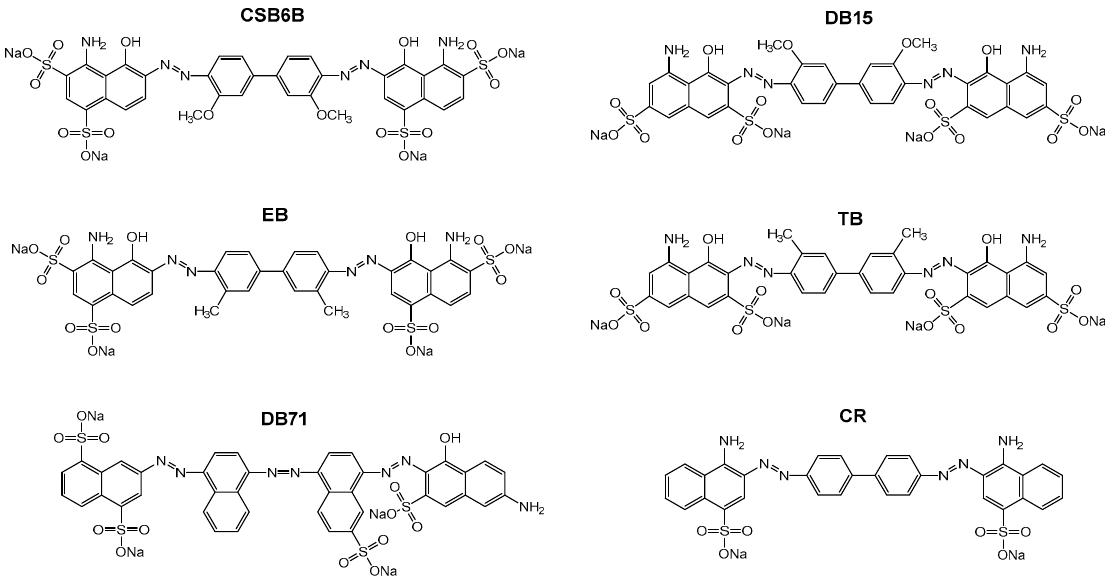
Figure 1. Structure of CSB6B and five sulfonated aryl diazo compounds that have structures similar to that of CSB6B, Evans blue (EB), Direct blue 15 (DB15), Trypan blue (TB), Direct blue 71 (DB71), and Congo red (CR).